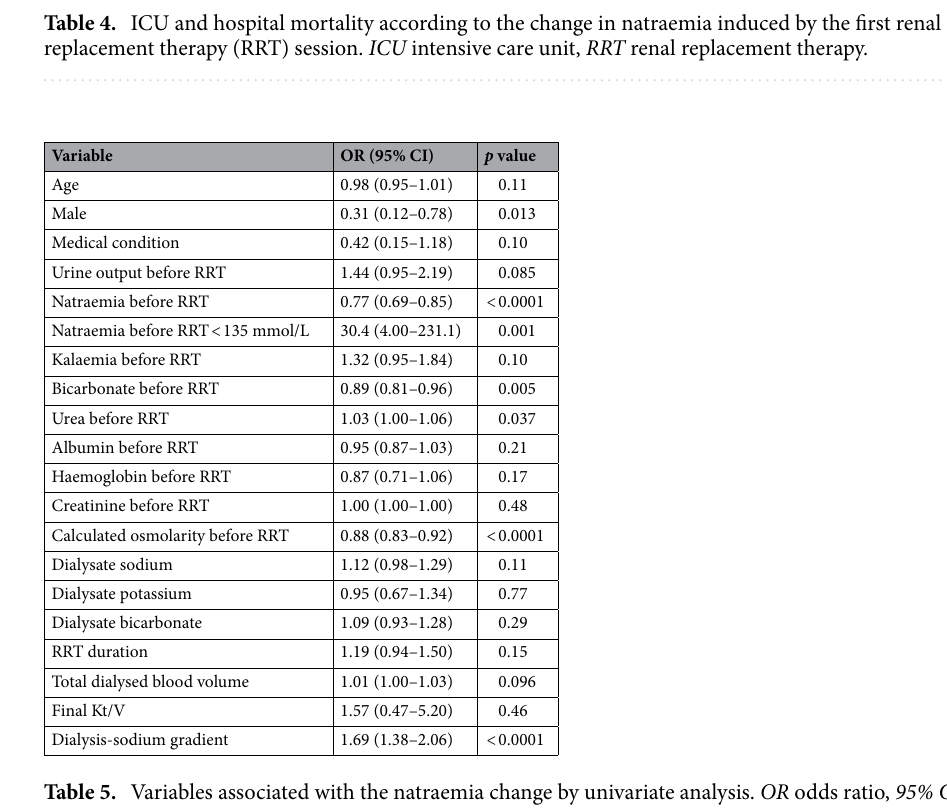
Table 5. Variables associated with the natraemia change by univariate analysis. OR odds ratio, 95% CI 95% confidence interval, RRT renal replacement therapy.